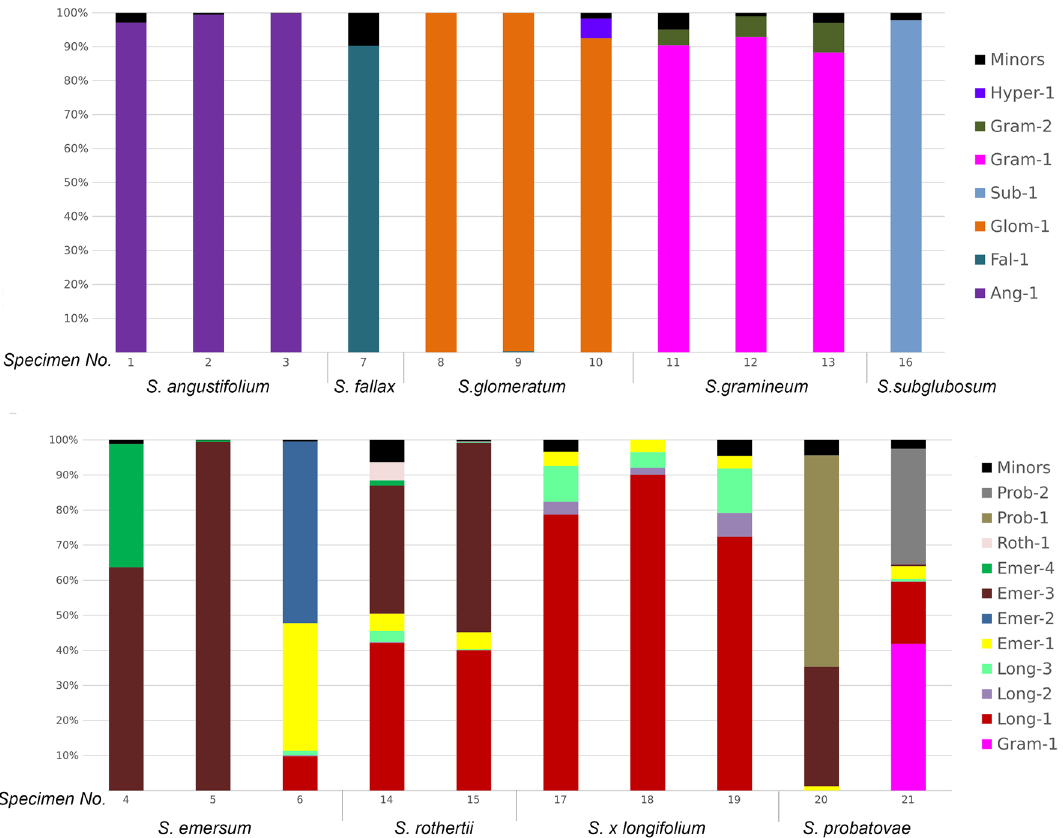
Figure 2. Stacked bar plots showing the relative abundance of the major ribotypes across the species of subgenus Xanthosparganium section Natantia . Minor ribotypes in a sample are collectively termed "Minors".